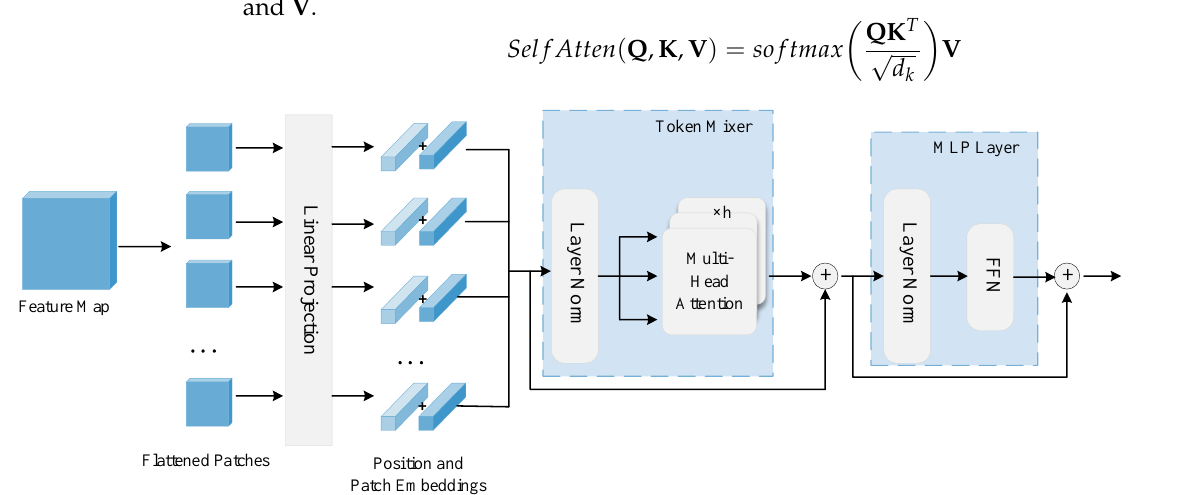
Figure 3. The structure of Transformer block.